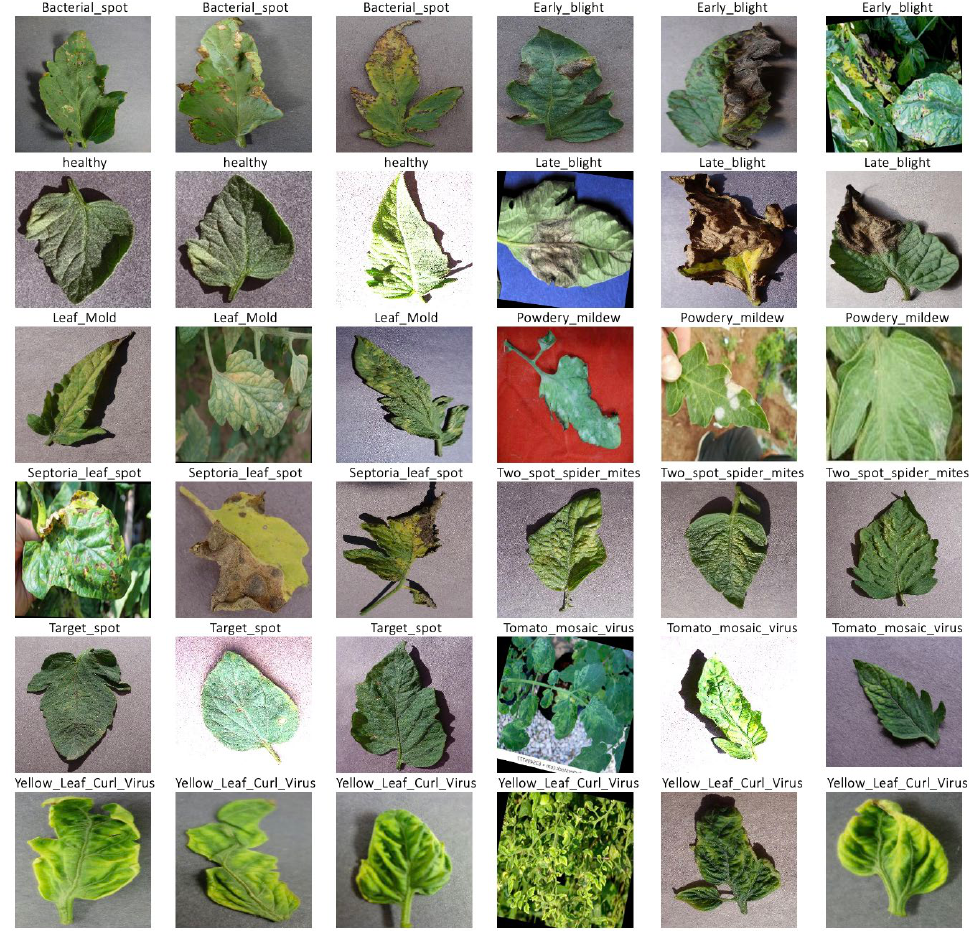
Figure 6. Sample images in the training set.